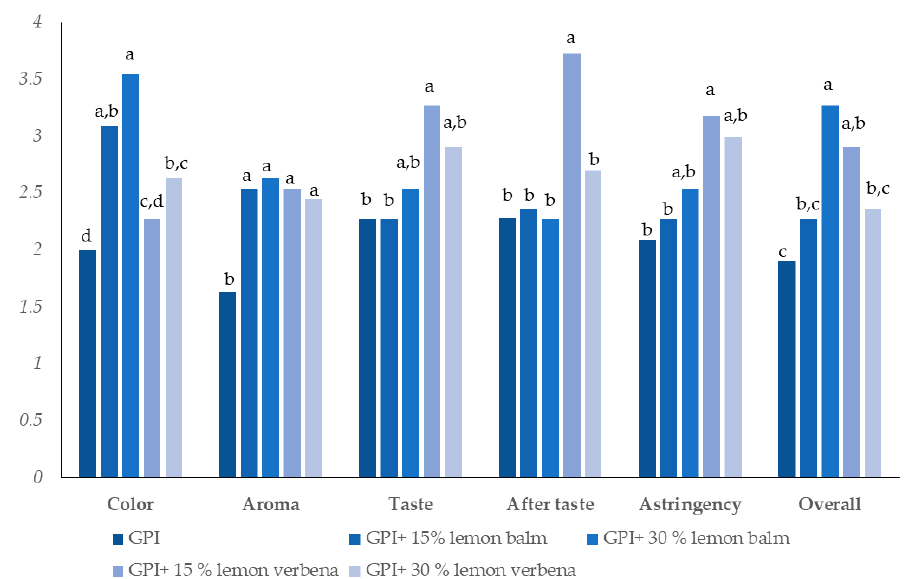
Figure 1. Mean values for sensory attributes of grape pomace infusions (GPI). Means with different letter are statistically different for each attribute.